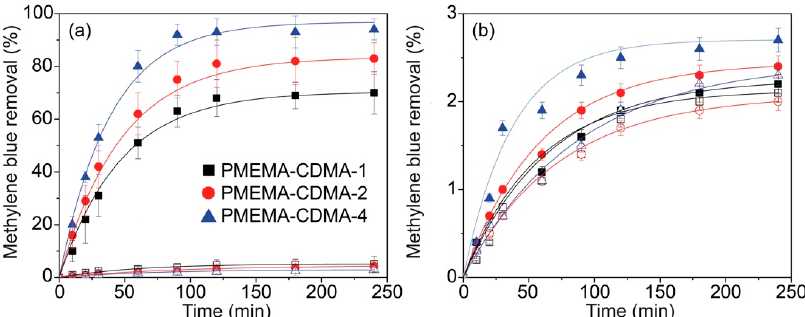
Figure 3. Variation of methylene blue removal with contact time for the adsorption of methylene blue onto PMEMA brush gels under pH > pKa ( a ) and pH < pKa ( b ) conditions at room temperature (filled symbols) and 40 °C (open symbols).